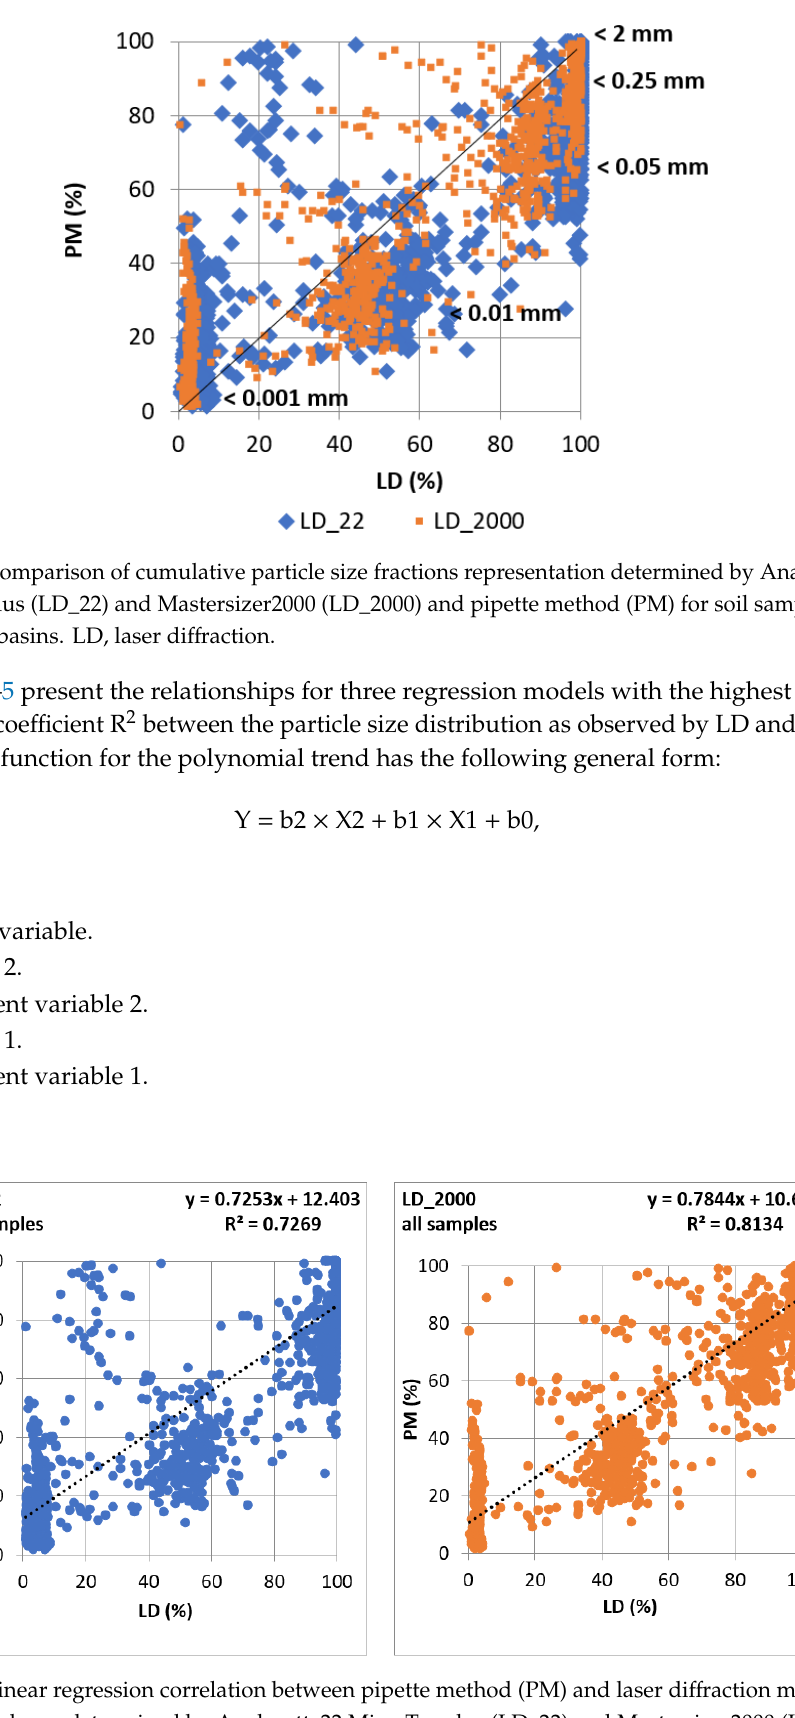
Figure 3. Linear regression correlation between pipette method (PM) and laser diffraction method for all soil samples as determined by Analysette22 MicroTec plus (LD_22) and Mastersizer2000 (LD_2000).